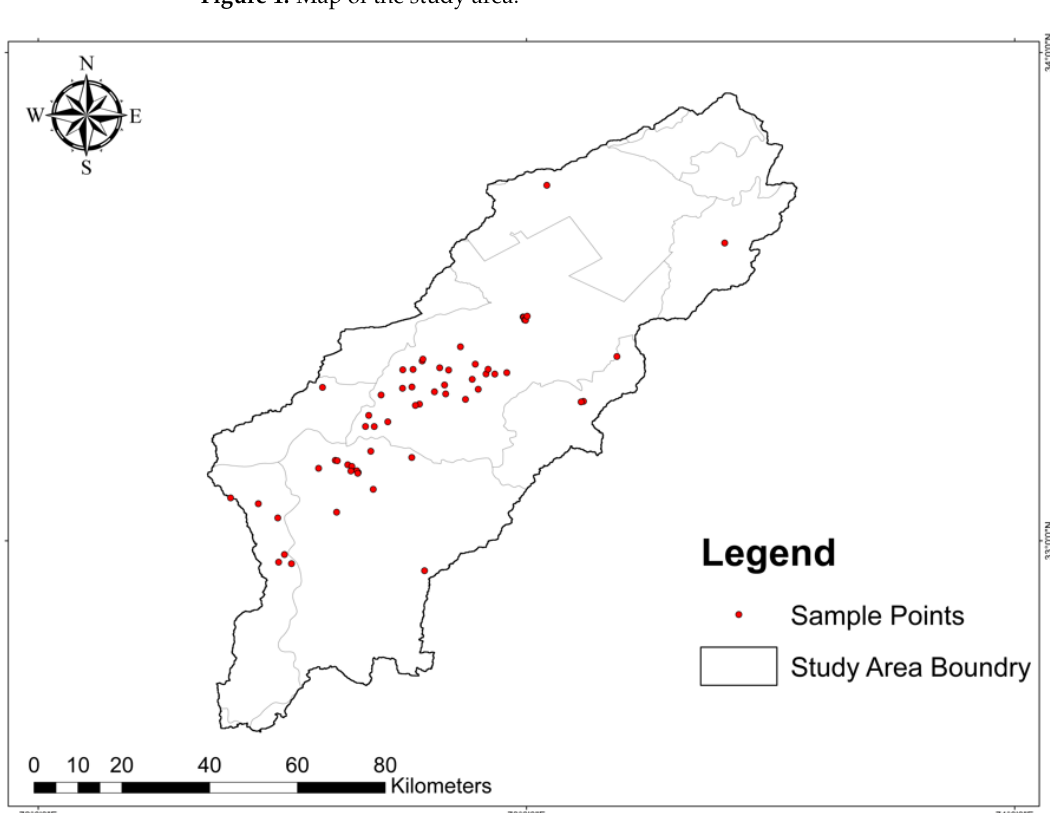
Figure 2. Geographical locations of dug wells’ sample points.